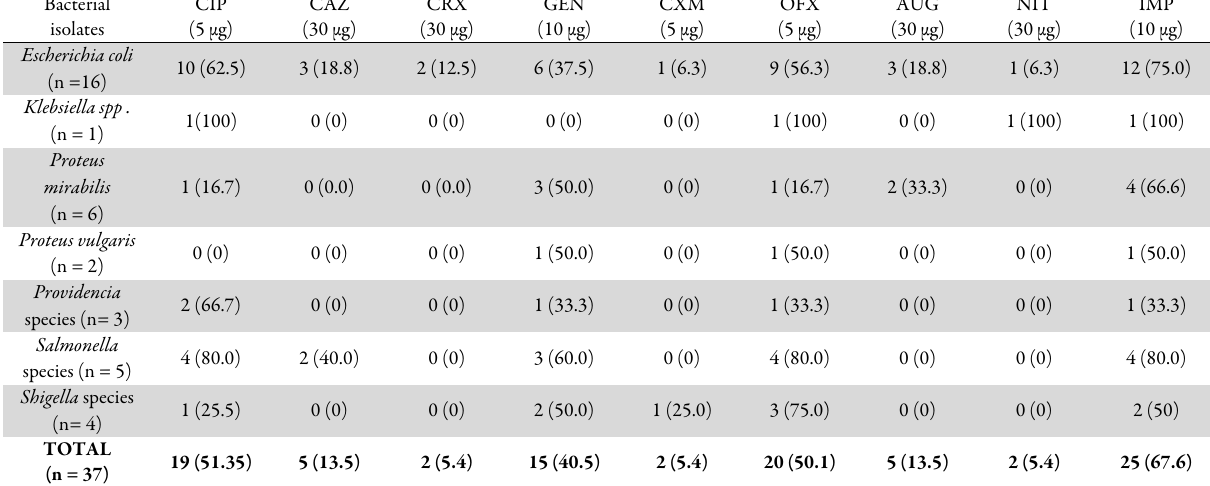
Table 3. Susceptibility profile of ESBL producing organisms recovered from cattle feces Bacterial isolates